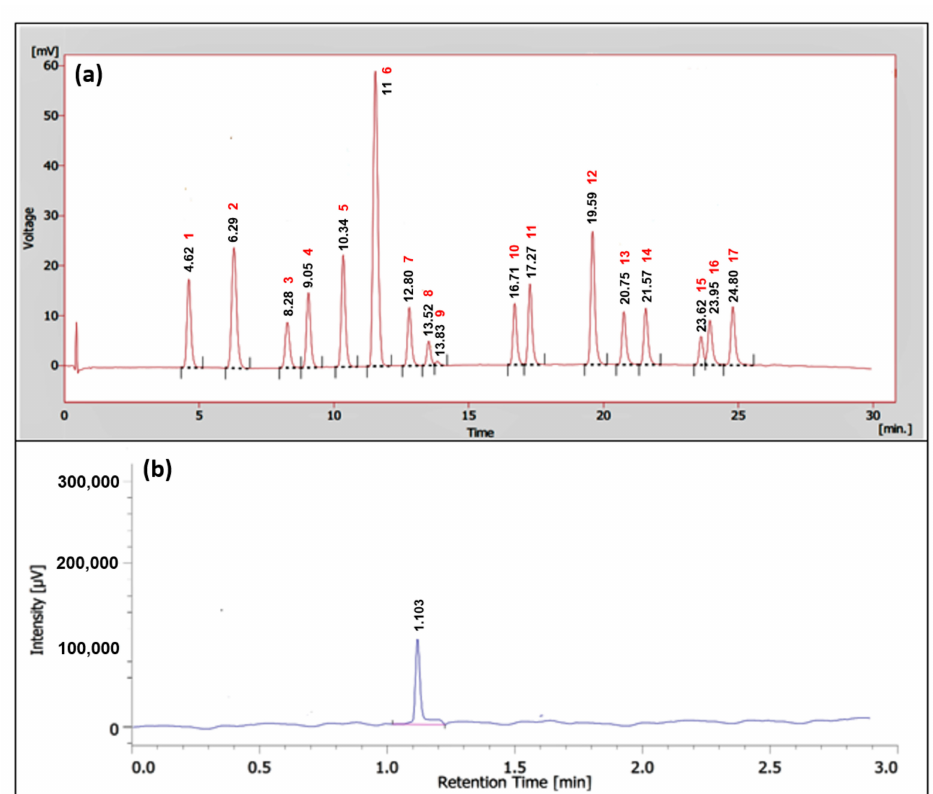
Figure 7. High Performance Liquid Chromatography (HPLC) chromatogram of ( a ) a fraction of AC n -hexane and ( b ) its isolated compound.